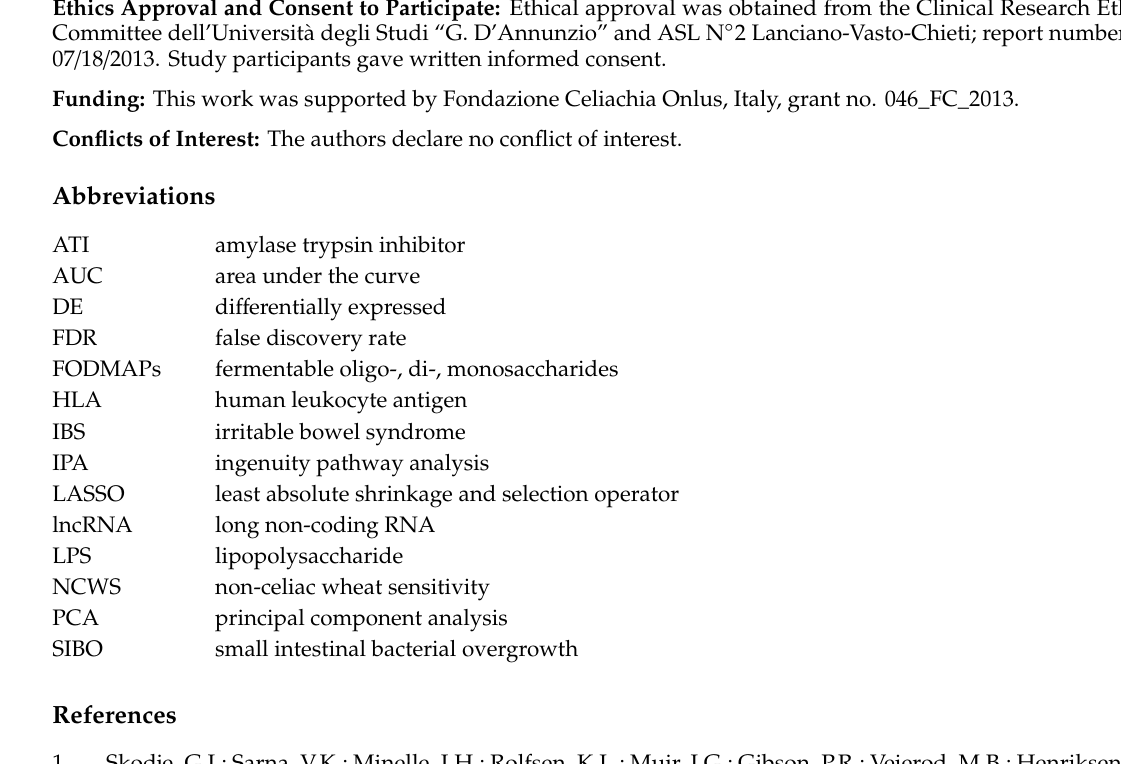
Figure S1. Frequencies of gene expression di ff erences between NCWS and controls. Figure S2. Heat map and PCA representation of the transcripts selected by LASSO. Figure S3. Intestinal malignancies sharing protein expression alterations with NCWS. Table S1. List of di ff erentially expressed